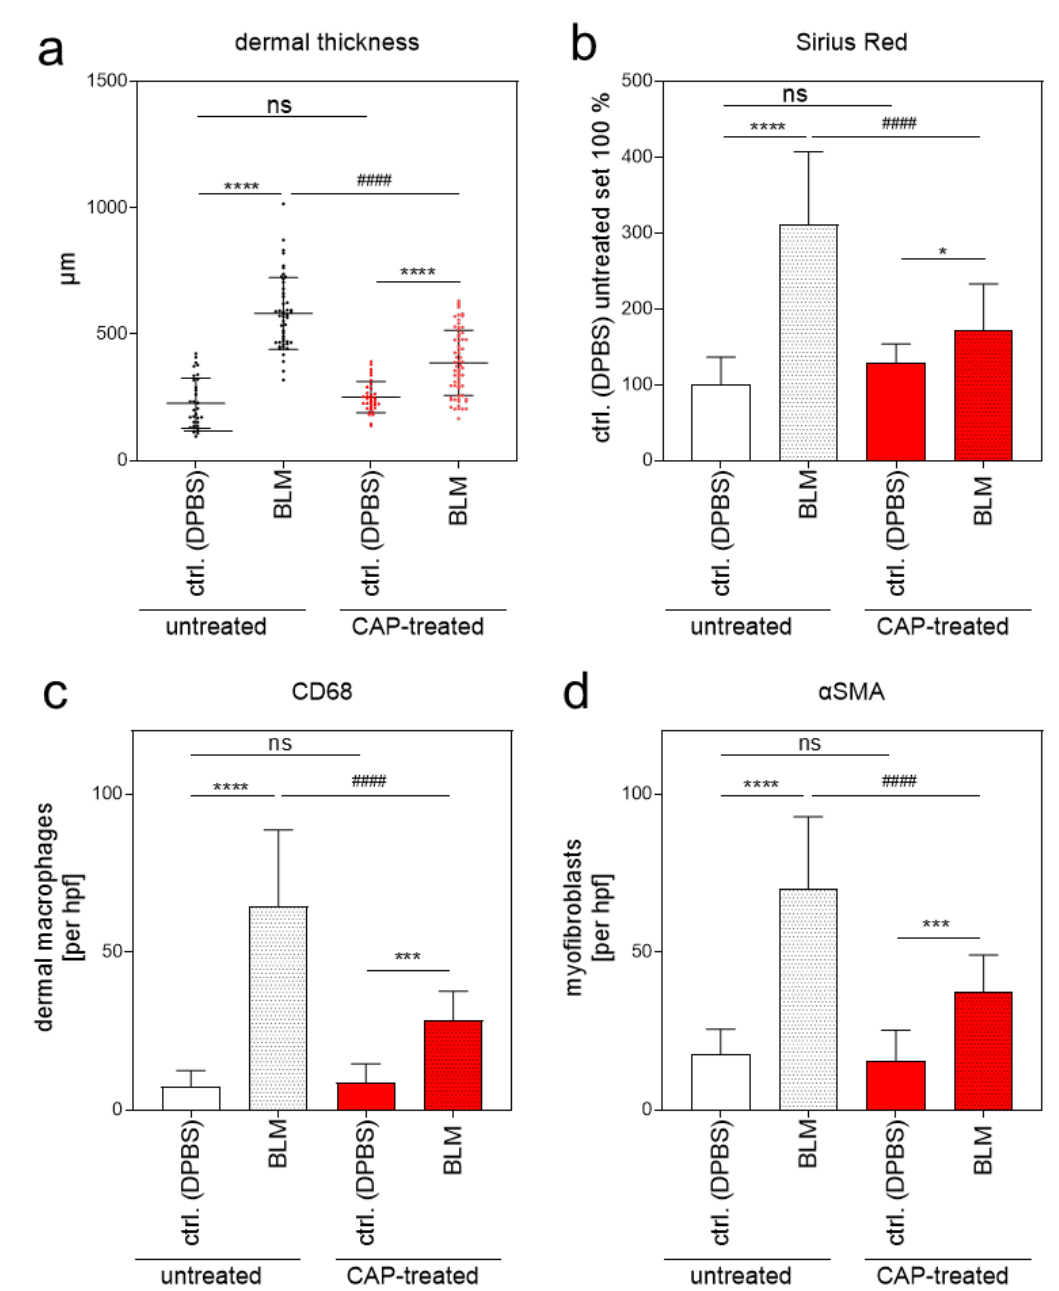
Figure 7. Evaluation of dermal thickness, collagen content, and the number of CD68-positive macrophages and α -SMA-positive myofibroblasts in a BLM-induced scleroderma model after 2 min CAP treatment. ( a ) Dermal thickness was determined in µ m in control skin (DPBS) ± CAP treatment, and in fibrotic skin (BLM) ± CAP treatment. Representative images of the mice ( n = 32; per group and treatment condition) were taken, and five measurements per image were used for calculation. ( b ) The six representative Sirius Red/Fast Green images per group and treatment condition were used for determining the fibrotic region by quantifying the Sirius Red-positive area by means of image analysis. ( c ) The number of CD68-positive macrophages was determined by counting the positively stained cells (average of three different hpf/animal; n = 6 animals per group and treatment condition) using 20 × magnification. ( d ) Quantification of α SMA-positive myofibroblasts (average of three different hpf/animal; n = 6 animals per group and treatment condition). Statistical analysis: Ordinary one-way ANOVA with Tukey ´ s multiple comparison test was used with * p ≤ 0.05, *** p < 0.001, **** p < 0.0001 to indicate the mean differences within the untreated or the CAP-treated group. #### p < 0.0001 indicates significant changes between untreated and CAP-treated groups in the BLM-induced fibrosis samples; ns = not significant. α SMA, alpha smooth muscle actin; hpf, high-power